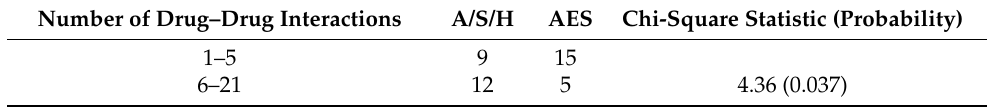
Figure 4. DDIs in the A/S/H and the AES subgroups. Table 8. Chi-square test of the distribution of drug–drug